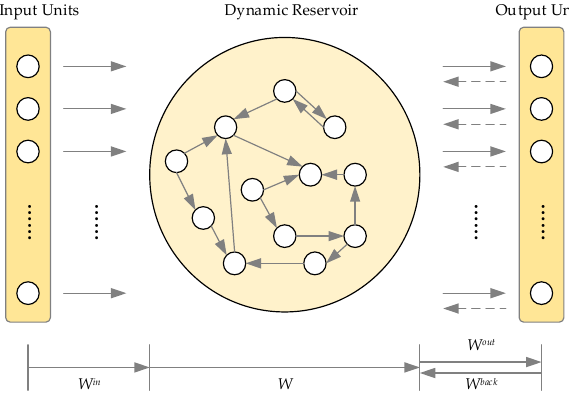
Figure 2. Typical echo state network structure.